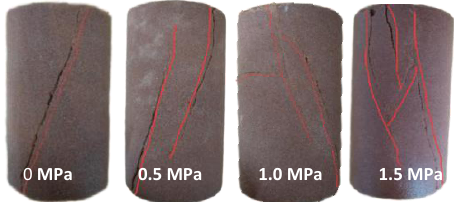
Figure 5. Failure modes under different seepage